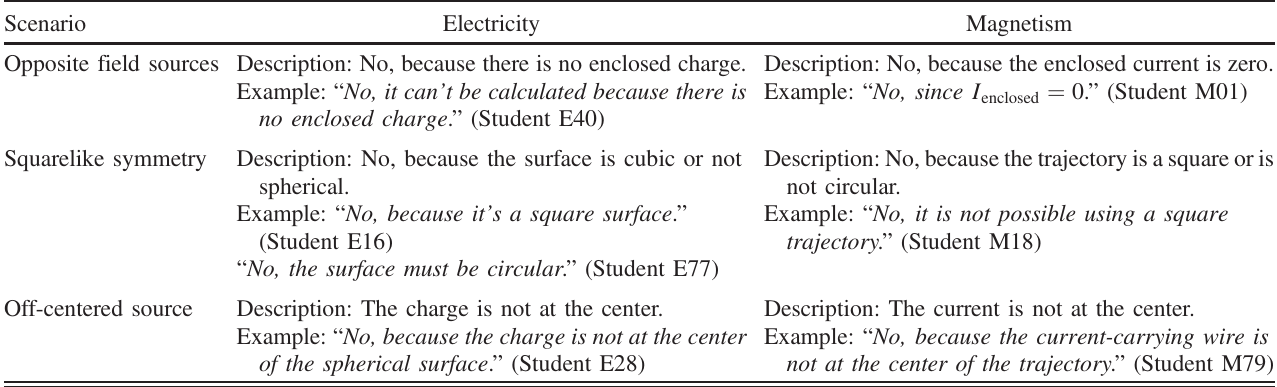
ANALYSIS AND COMPARISON OF STUDENTS ’ TABLE III. Description and example of student ’ s reasoning in the category surface features restrict for each scenario. Scenario Electricity Magnetism